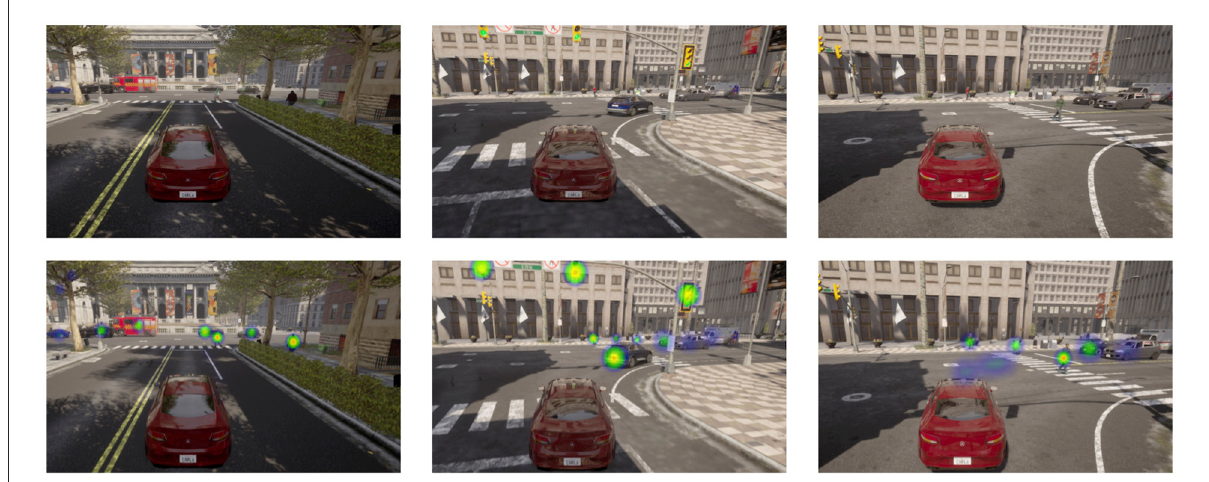
FIGURE6 Visual attention. The first row is the original image. The second row is the attention image. The dual-flow network focuses on areas near vehicles, pedestrians, and traffic lights.